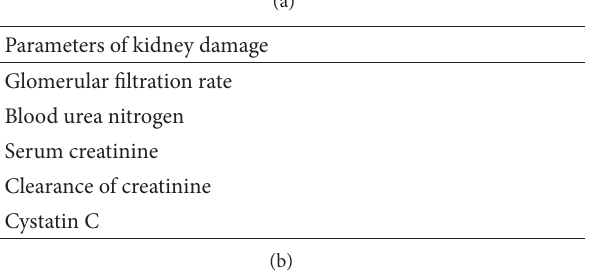
Table 3: (a) Parameters of kidney damage. (b) Hepatic damage